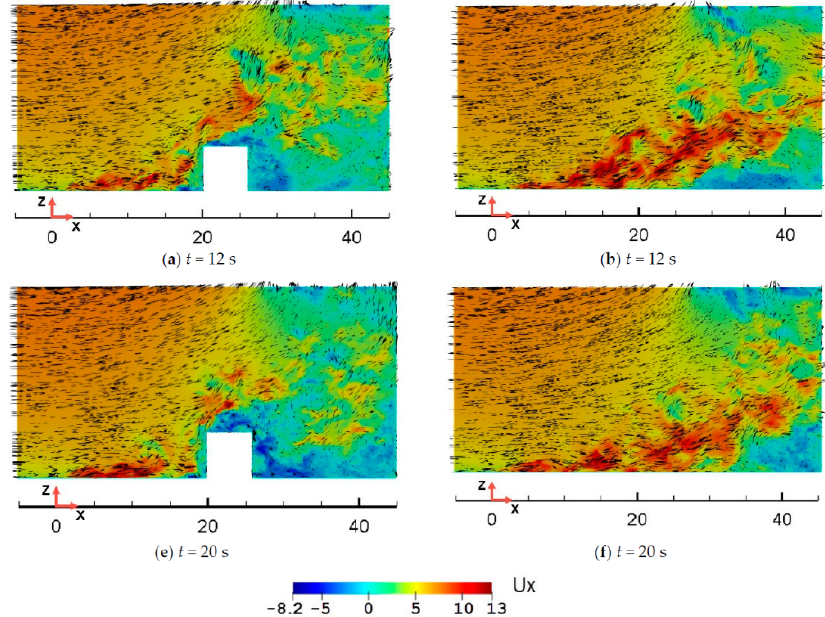
Figure 1. In subfigures ( a ) and ( e ) the white box instances the presence of a 6 m cubic building. Subfigures ( b ) and ( f ) show the fire passing by the building 9 m distance from its center. I.e., 6 m from the side [33] (p. 9). Colorbar represents velocity in m/s along x axis.